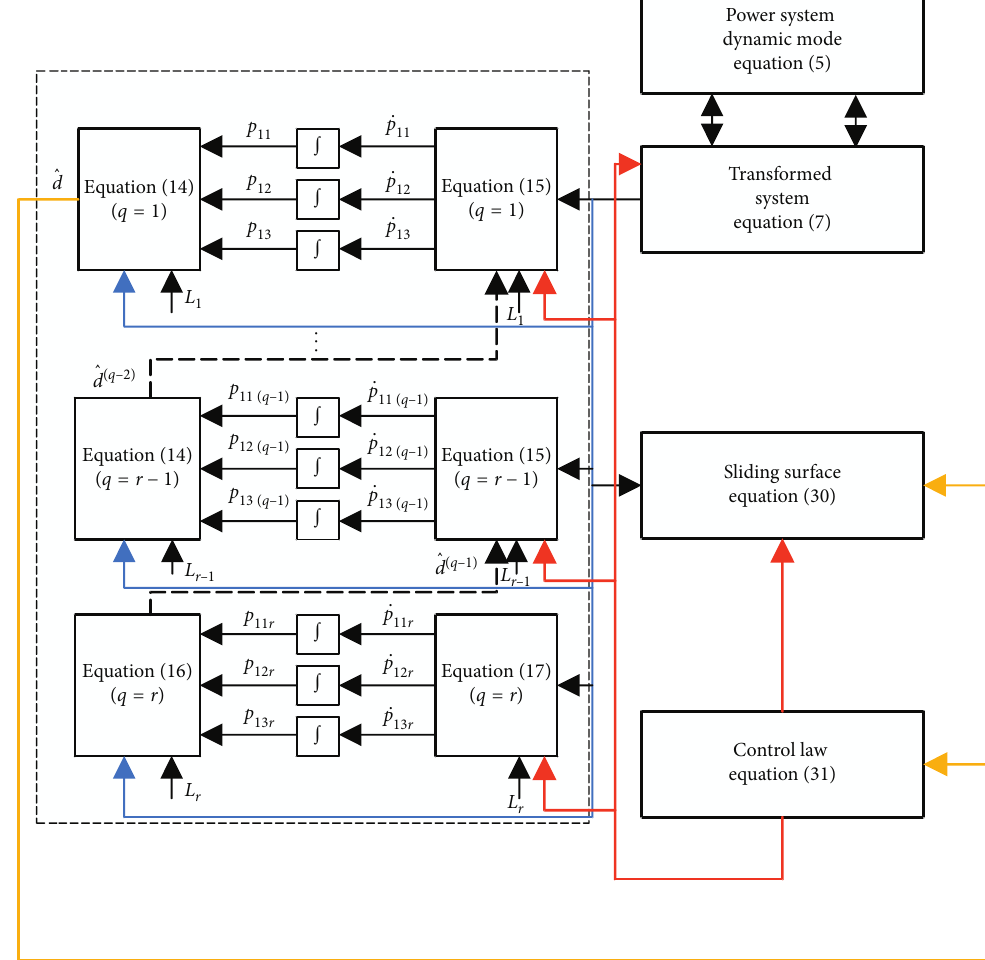
Figure 2: Block diagram of the system with the proposed SMC. Table 1: The parameters of power systems.